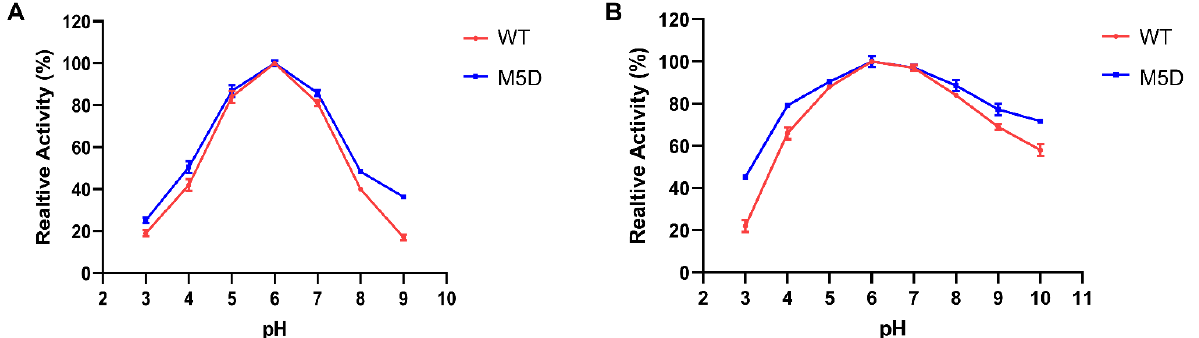
Figure 4. Optimal pH ( A ) and pH stability ( B ) of the WT and M5D mutants. Error bars represent standard deviations between replicates.